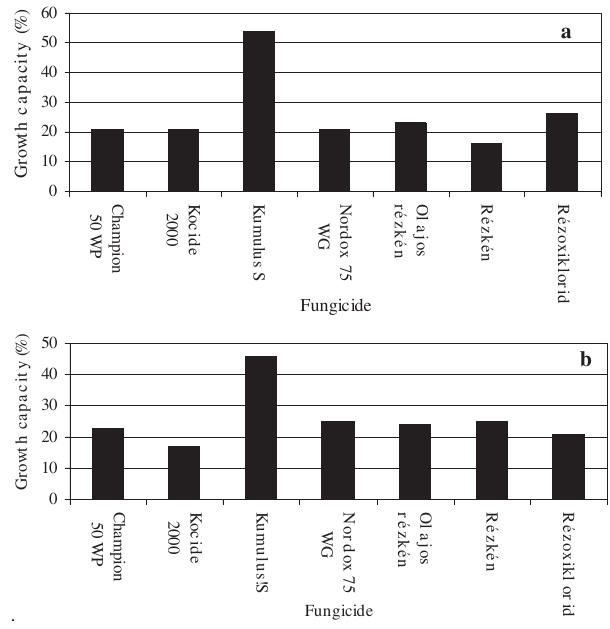
Figure 1. Percent growth capacity of two Monilinia laxa isolates (a and b) for 7 fungicides (organically approved) admended on PDA plates at 1 x dosage recommended by the manufacturer.